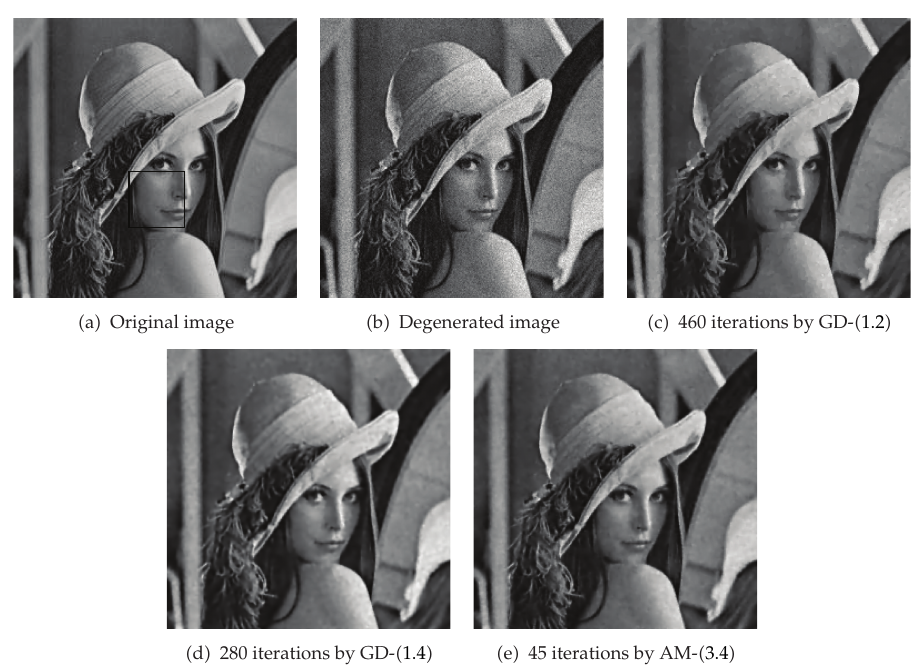
Figure 1: Recovered results of di ff erent models by di ff erent numerical